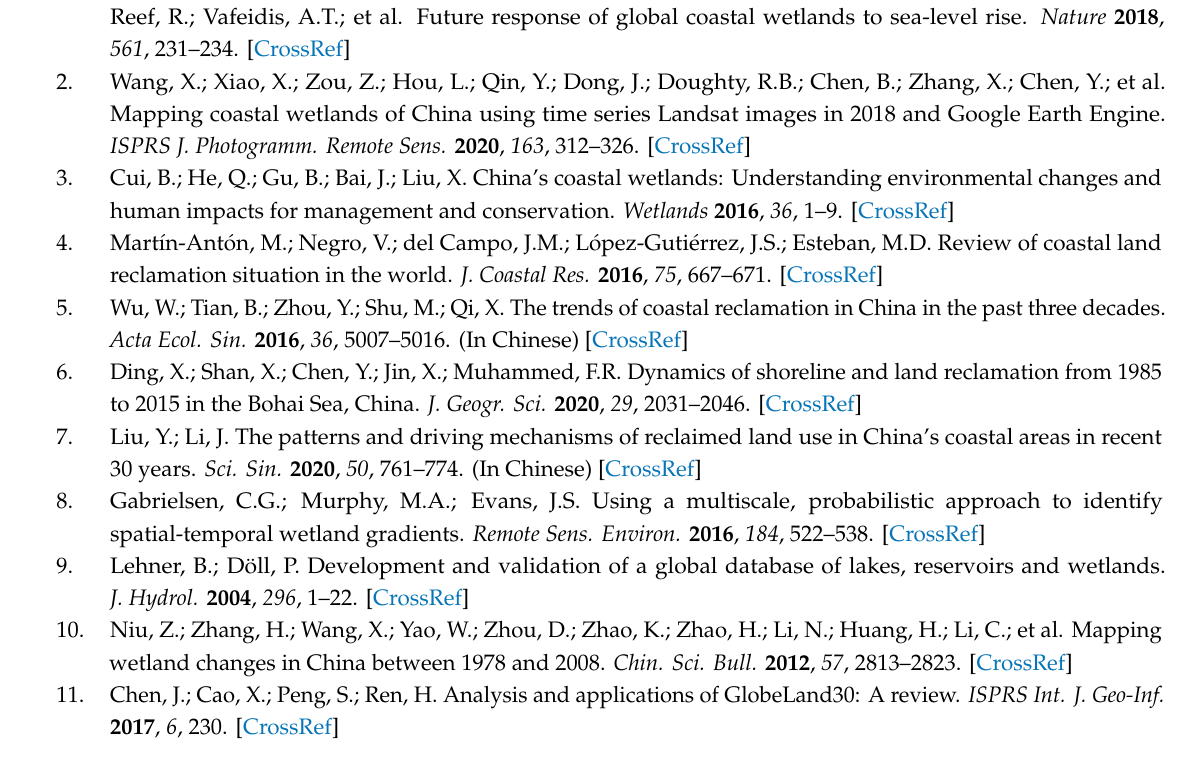
Figure S1: Spatial distributions of the training samples and validation samples; Table S1: Statistics of the area of the Bohai rim coastal wetlands based on di ff erent data